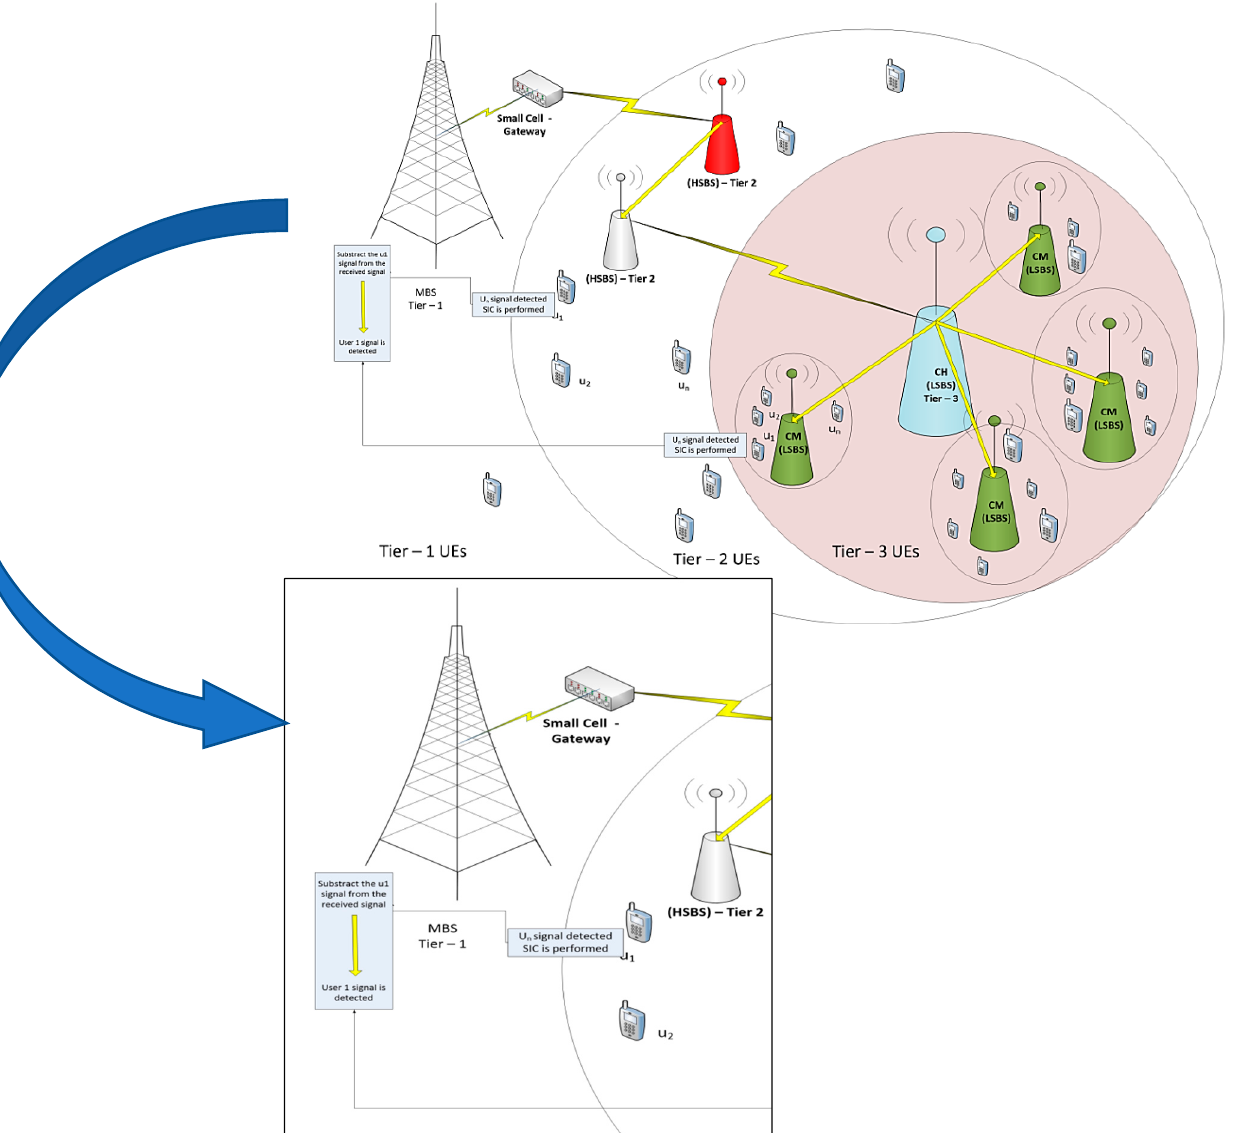
Figure 2. System model of clustered PD-NOMA implemented at an SBS-tier on randomly deployed ultra-dense SBSs with the magnified view of PD-NOMA implementation at tier 2 and tier 3.